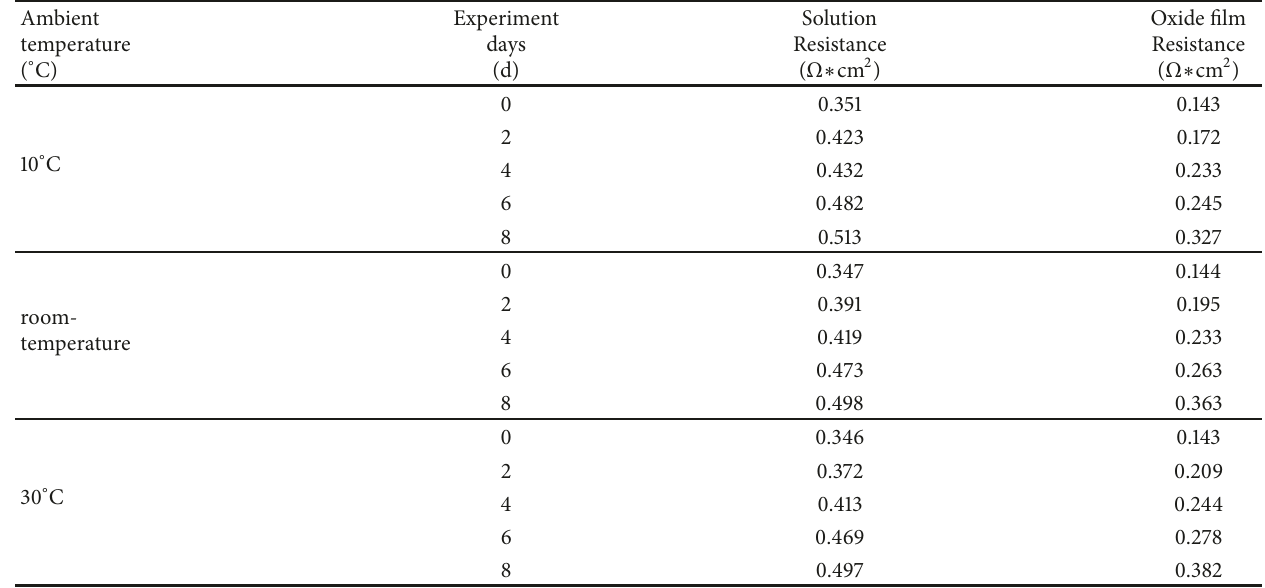
Table 7: The resistance parameters of the fitted equivalent circuit.